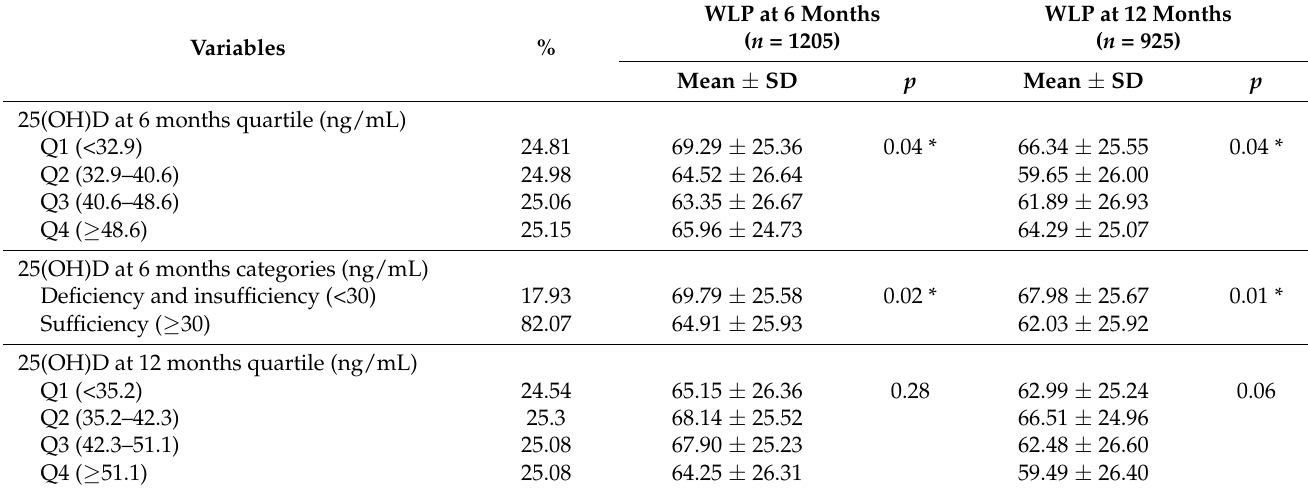
Table 2. Univariate analysis of factors associated with weight-for-length percentile (WLP) in infants at 6 and 12